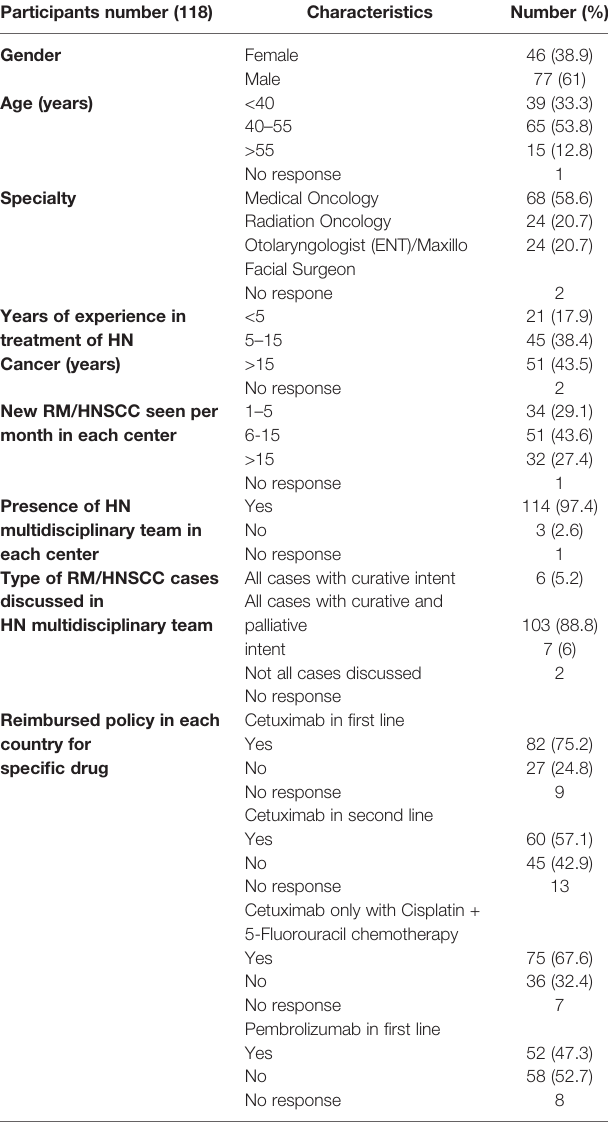
TABLE 1 | Participants